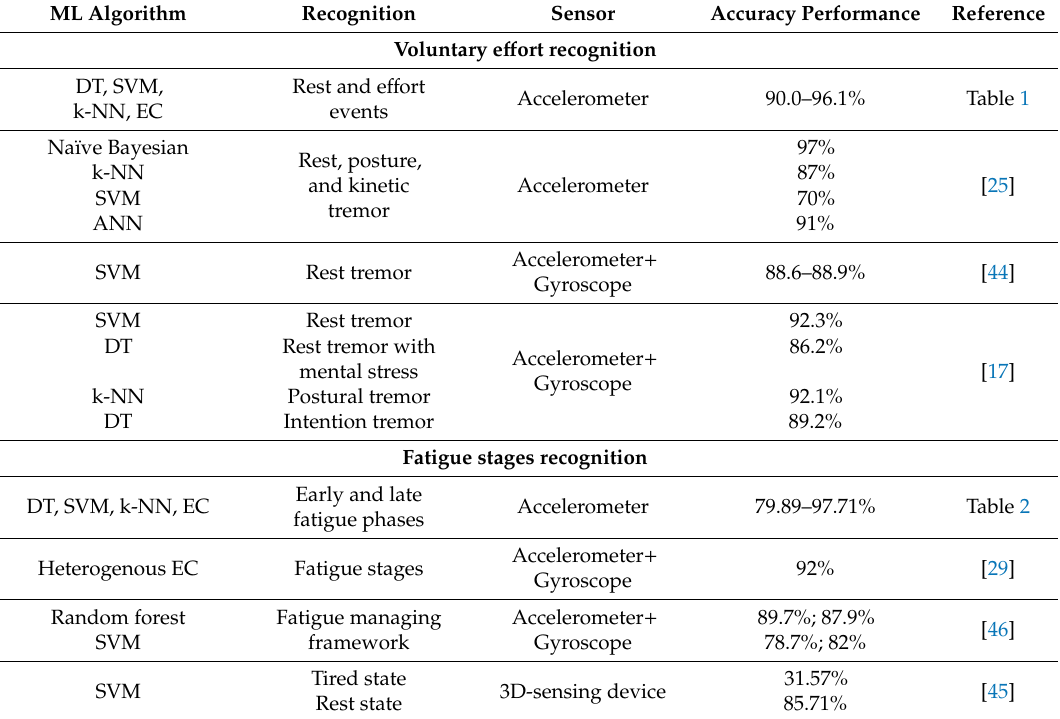
Table 4. E ff ectiveness of the proposed model and existing